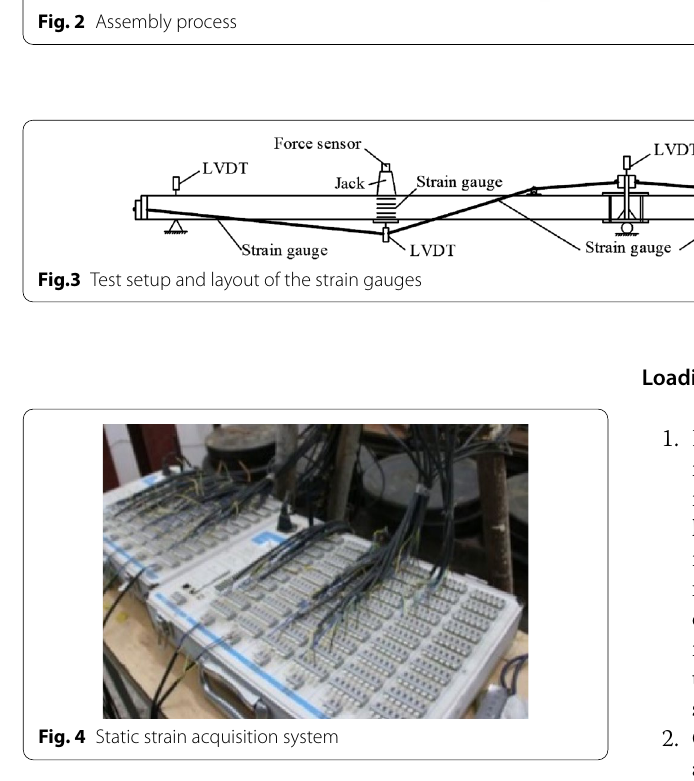
Fig. 2 Assembly process